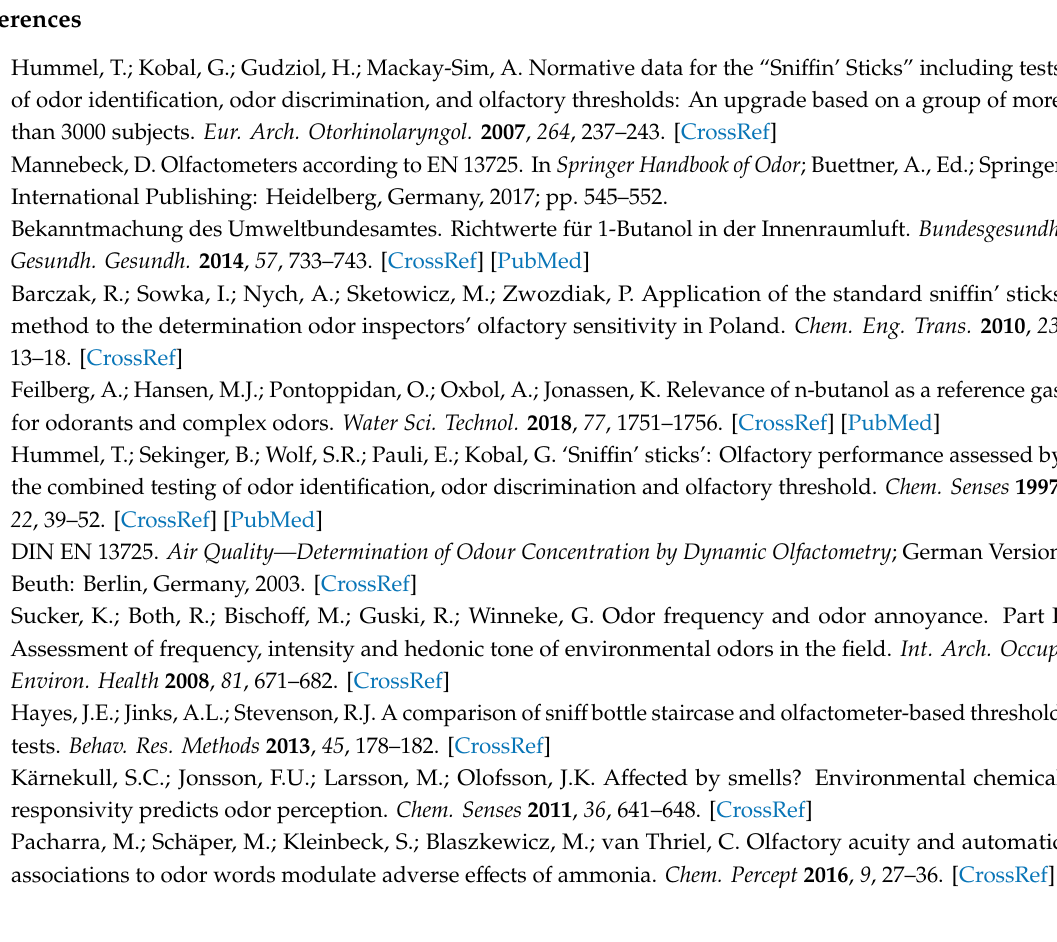
Figure S1: Schematic overview of the experimental procedure during the exposure lab-based threshold assessment. Figure S2: Measured concentration values for n-butanol during the exposure lab-based threshold assessment. Figure S3: Schematic overview of the experimental procedure during the ammonia exposure (cf. [11,12]). Figure S4: Measured concentration values of ammonia during the experimental exposure. Table S1: Descriptive statistics for the total sample and